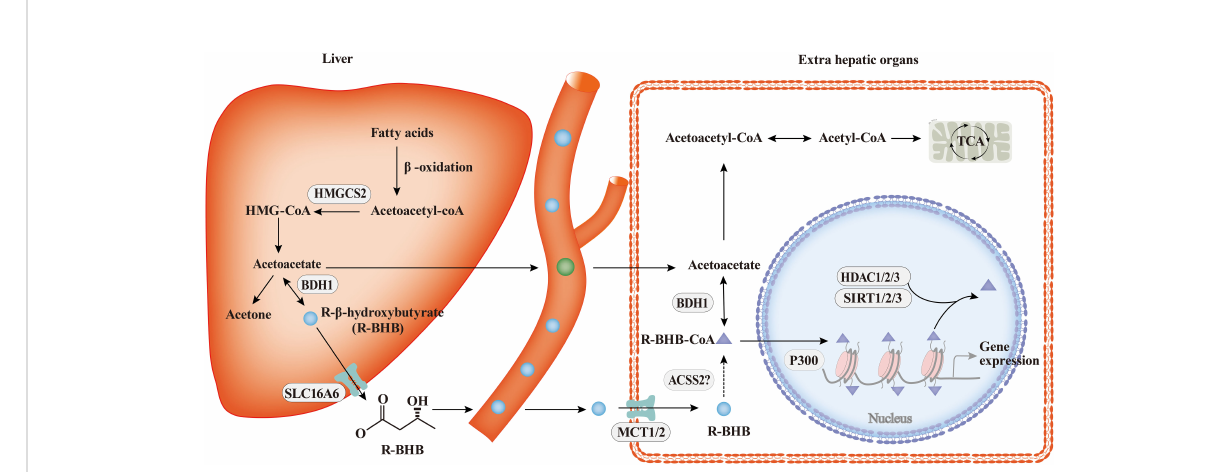
FIGURE 2 The process of ketone body metabolism and histone Kbhb. In hepatocytes of the liver, fatty acid b -oxidation generates BHB by HMGCS2 and BDH1, the key enzymes of ketone body metabolism, BHB is transported to extrahepatic organs via MCT1/2 and act as important sources of energy for the heart and brain during starvation by the tricarboxylic acid cycle (TCA). In addition to serving as an energy source, BHB can be converted into BHB-CoA by ACSS2, this process promotes histone Kbhb which regulate genes and mediate classical responses to carbohydrate restriction effectively. Histone Kbhb is dynamically regulated by the opposing enzymatic activities of histone acetyltransferases (HATs) and histone deacetylases (HDACs). The acyltransferase p300 act as “ writer ” to catalyze histone Kbhb modi fi cation, and HDAC1, HDAC2, HDAC3 and SIRT1, SIRT2, SIRT3 were reported to be the “ erasers ” enzymes that have been identi fi ed for de- b -hydroxybutyrylation. Histone Kbhb exerts diverse functions as described in detail